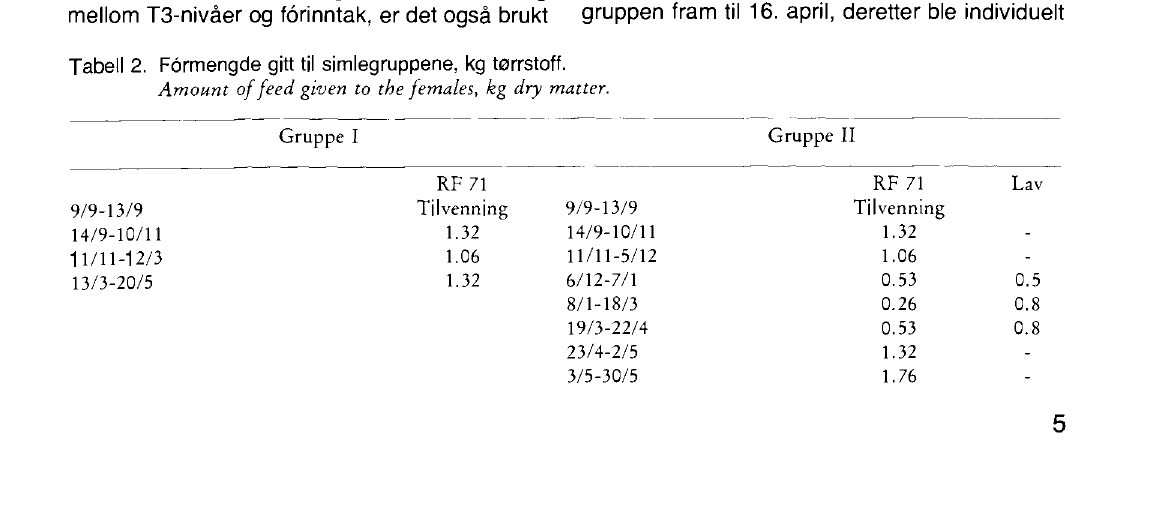
Tabell 2. Formengde gitt til simlegruppene, kg tørrstoff. Amount of feed given to the females, kg • dry